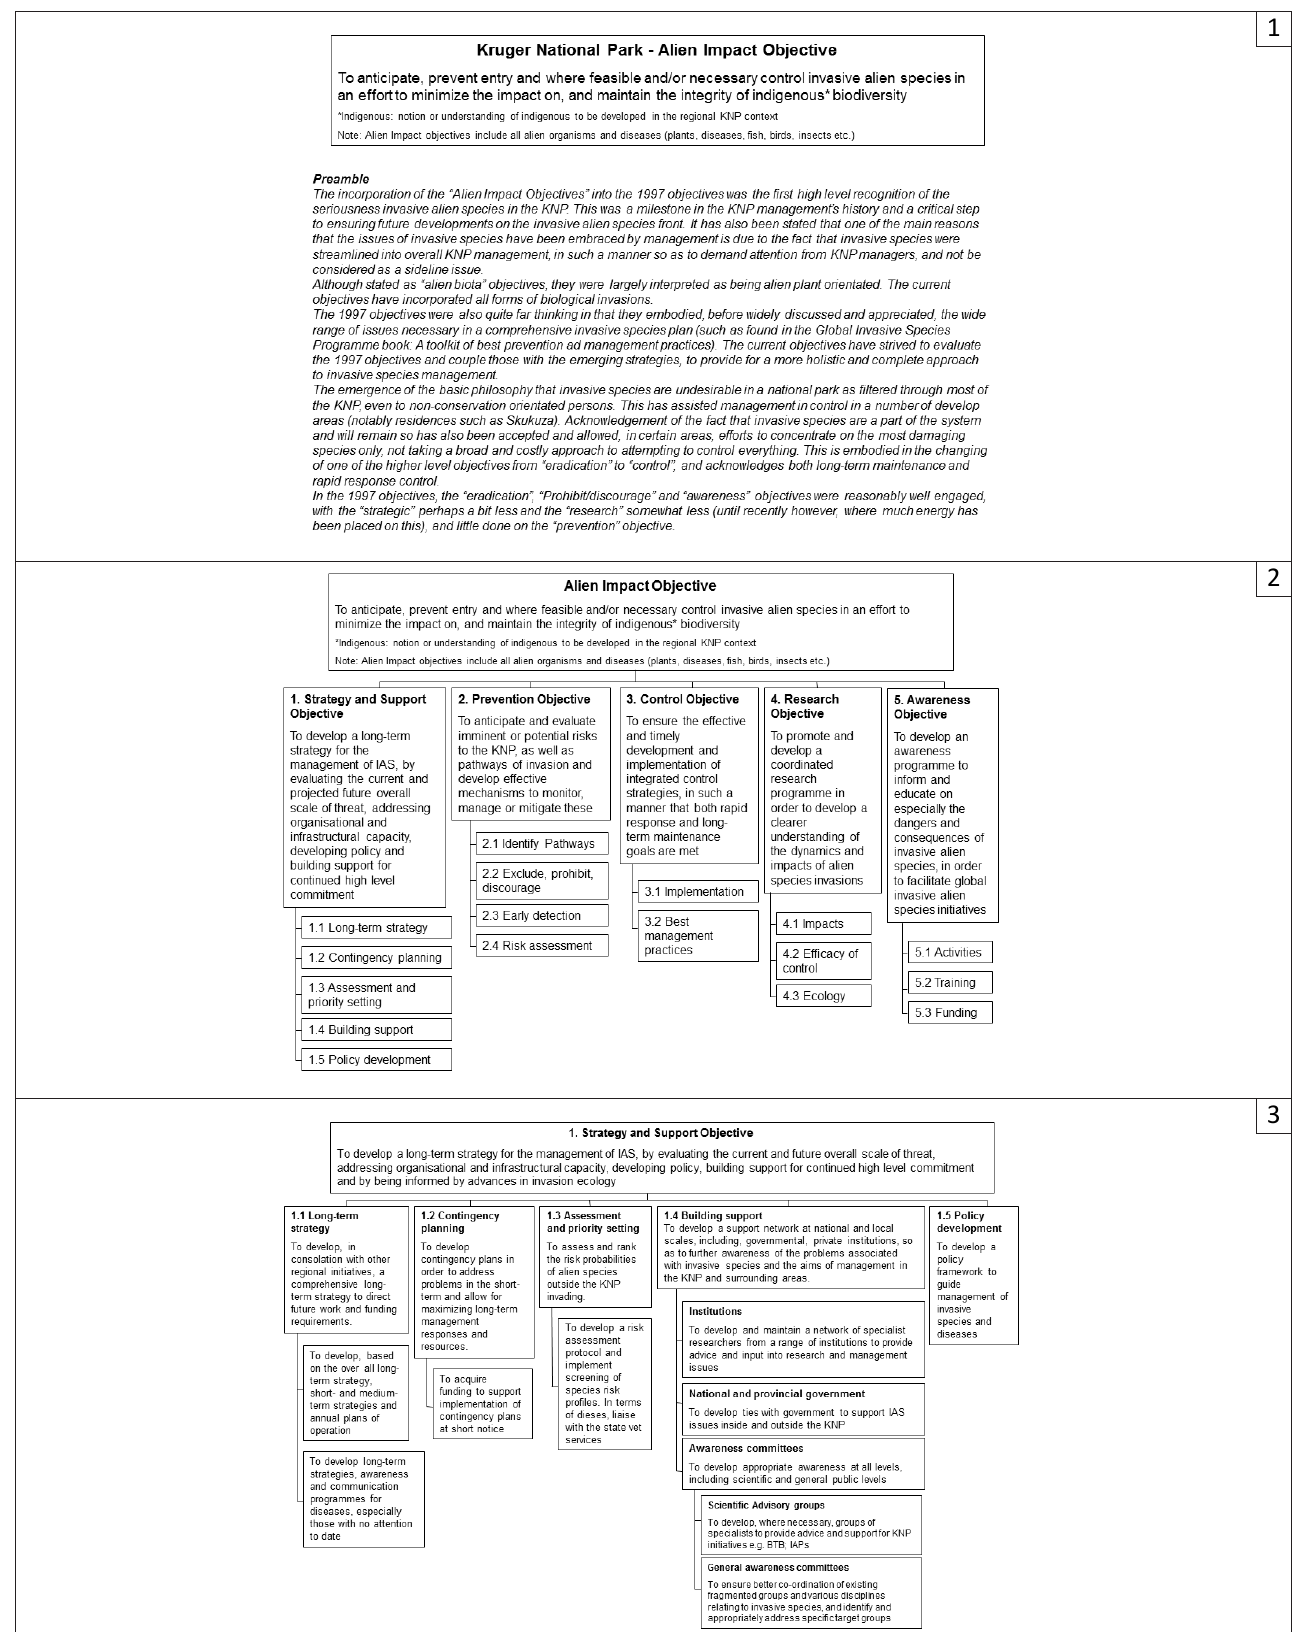
FIGURE 1: An expanded overview of the proposed framework to implementing the control of invasive alien species. The framework indicates the key components, with the salient points, and their linkages. The numbers cross link to the discussion. We also differentiate between documents, activities and/or processes, actions, and bodies and/or